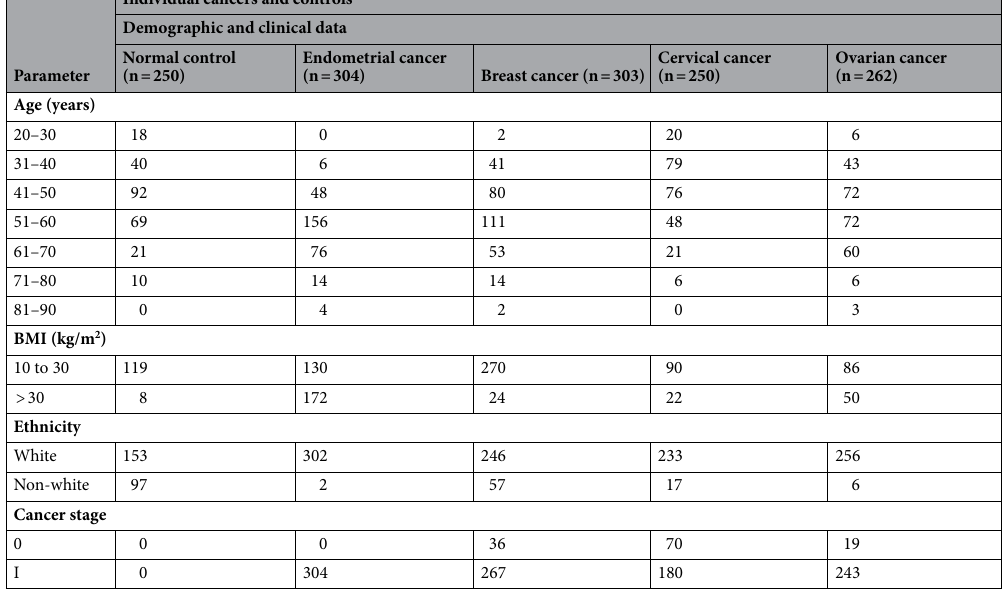
Table 1 details the sample set employed for the present study. The number of samples for each of the target cancers is shown, along with the number of normal control samples. Majority of the samples were from women between the ages of 30–80 years, although a few samples from women in the 20 to 30- and 81 to 90-year age groups were also included (Table 1). Donors were predominantly Caucasian women (87%), with a lesser number of non-White donors, which included African American, Hispanic, and Asian women (Table 1). Thus, the cumulative number of samples employed for the